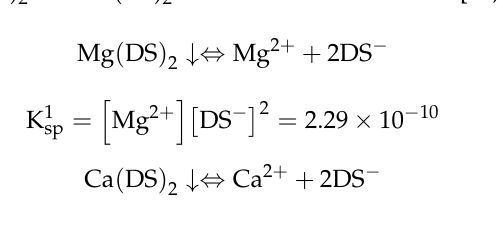
Figure 11. FTIR spectra of before and after action between collophane and SDS.